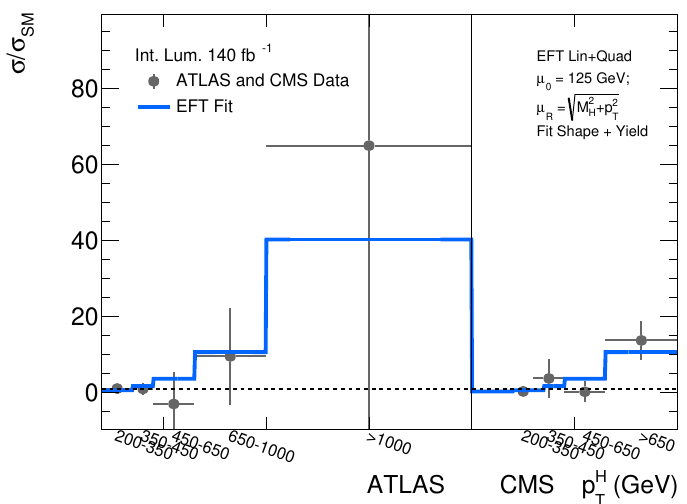
Figure 13. Result of a simultaneous fit to the spectrum shape and Higgs signal rate of ATLAS (left) and CMS (right) using the SMEFT expansion with linear and quadratic terms at µ 0 = 125 GeV. The points with error bars show the data and the continuous line the best fit corresponding to c g ( M H ) = − 0 . 08 and c tg ( M H ) = − 0 . 13 .